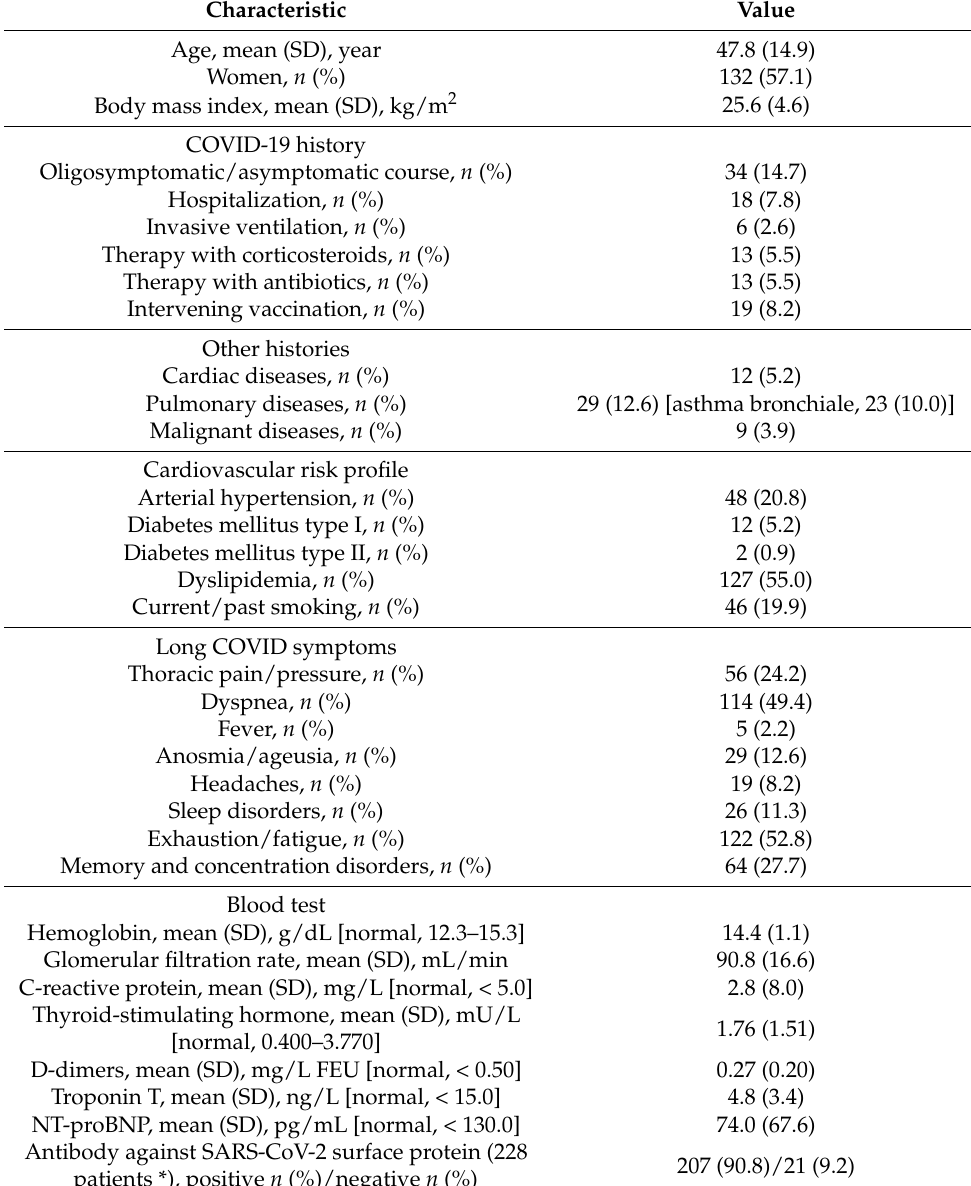
Table 1. Patient Characteristics ( n =